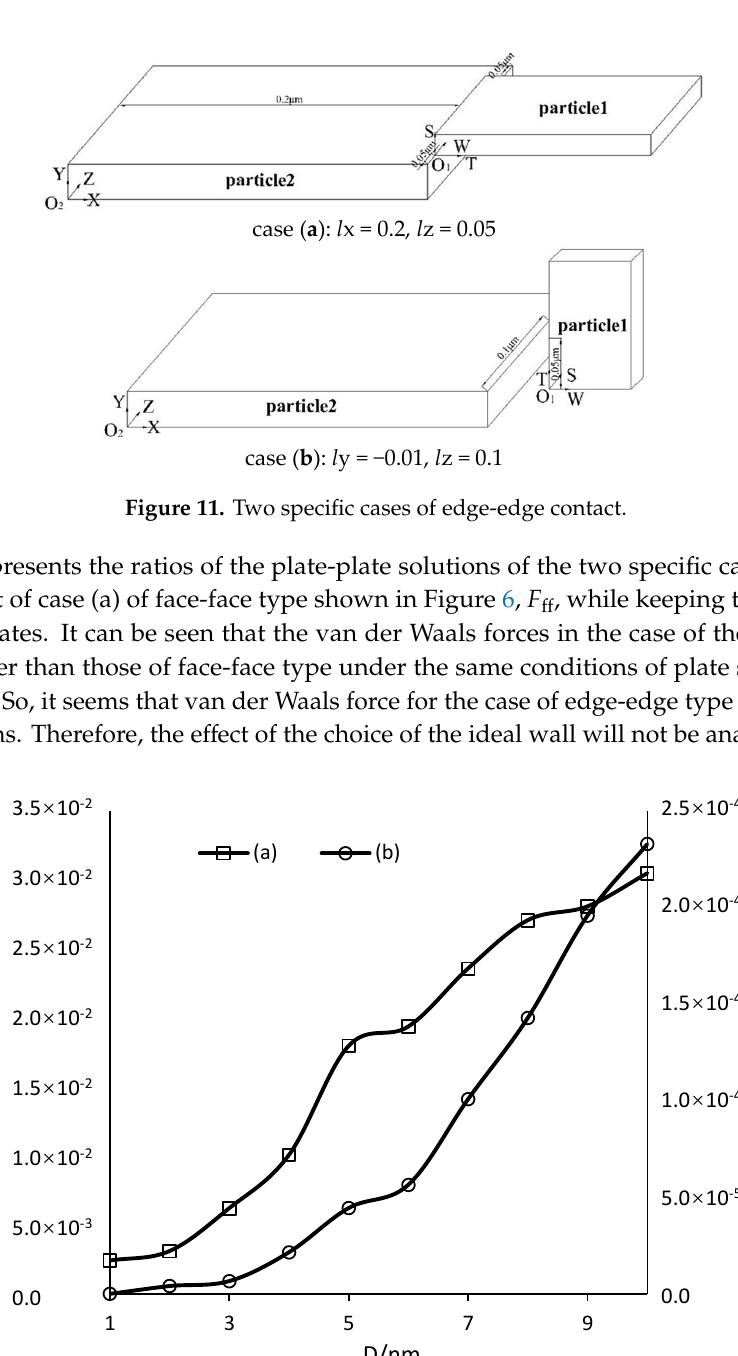
Figure 10. Comparison of the calculated force of different choices based on projection procedure.